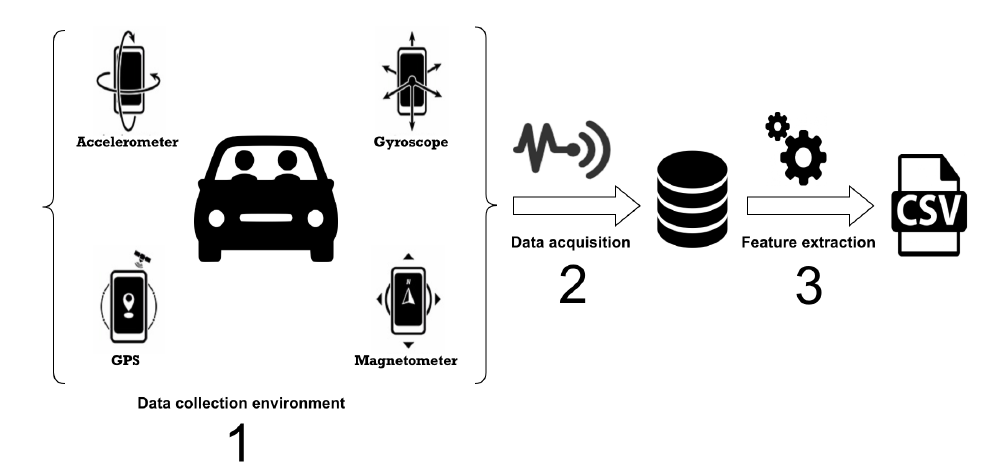
Figure 1. Abstract view of dataset acquisition and feature